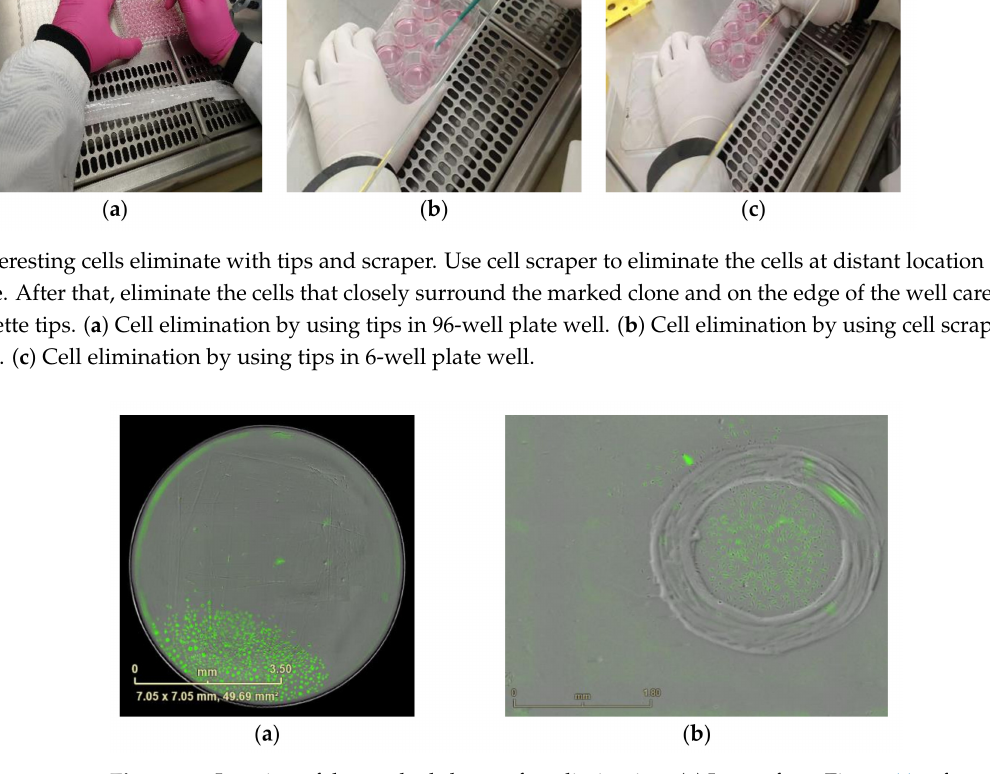
Figure 13. Imaging of the marked clones after elimination. ( a ) Image from Figure 11a after elimination and two days incubation, Scale bar = 3.6 mm. ( b ) Image from Figure 11b after elimination and two days incubation. Scale bar = 1.8 mm.